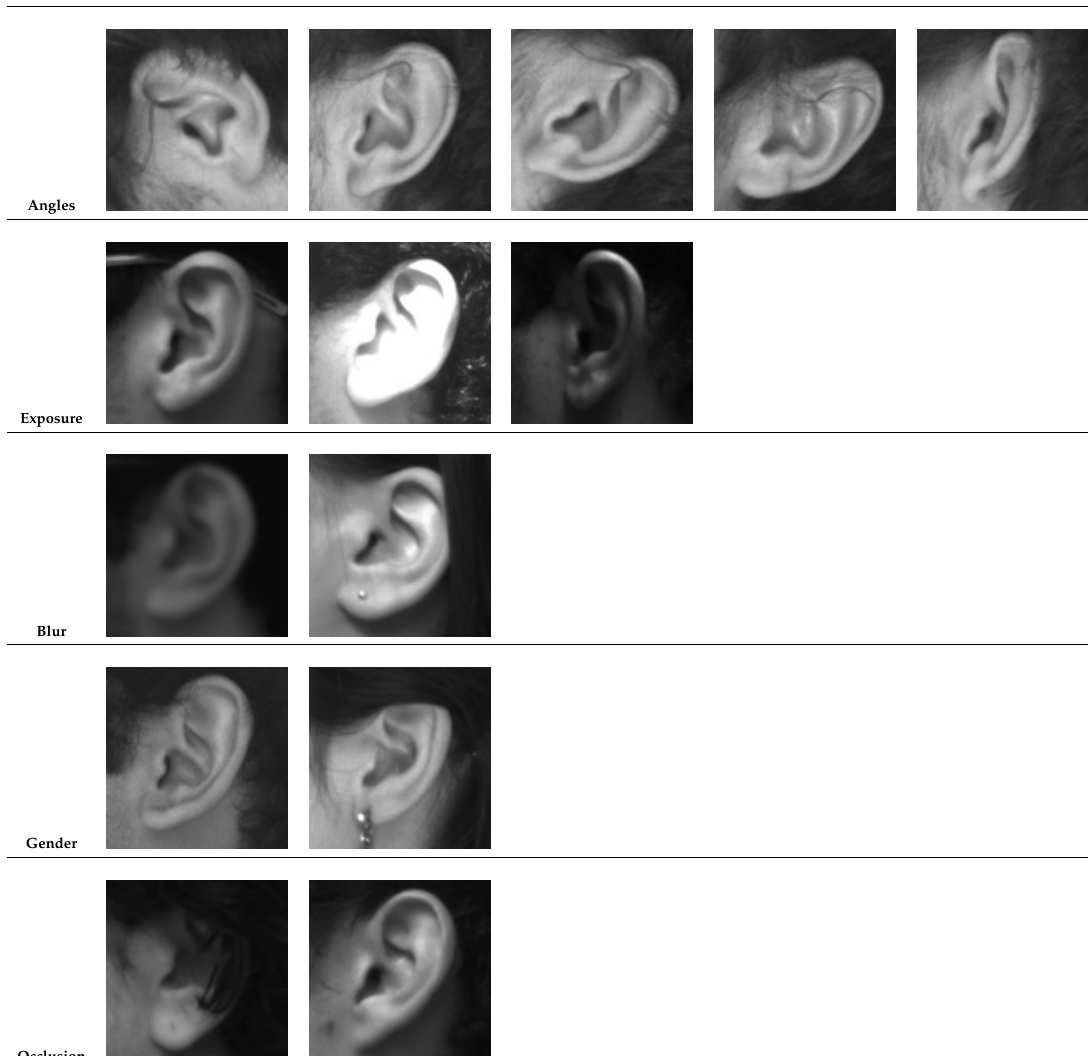
Table 3. Differences and challenges presented in the UBEAR